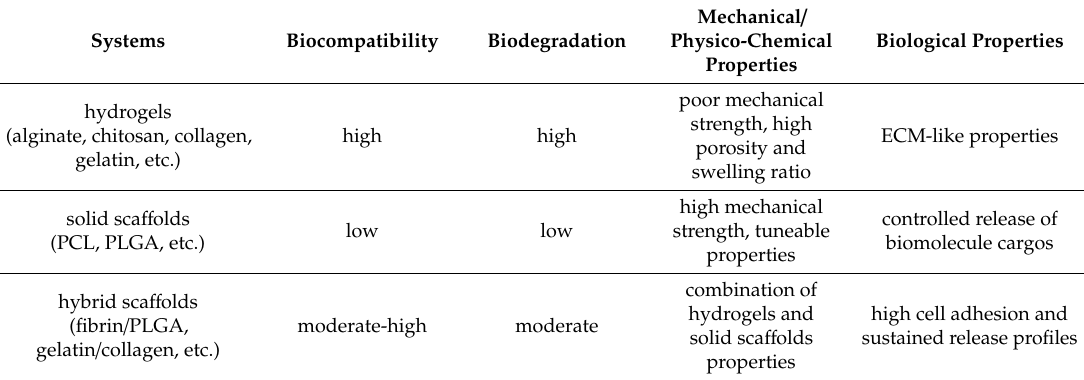
Table 2. Properties of sca ff olds used for osteochondral repair.